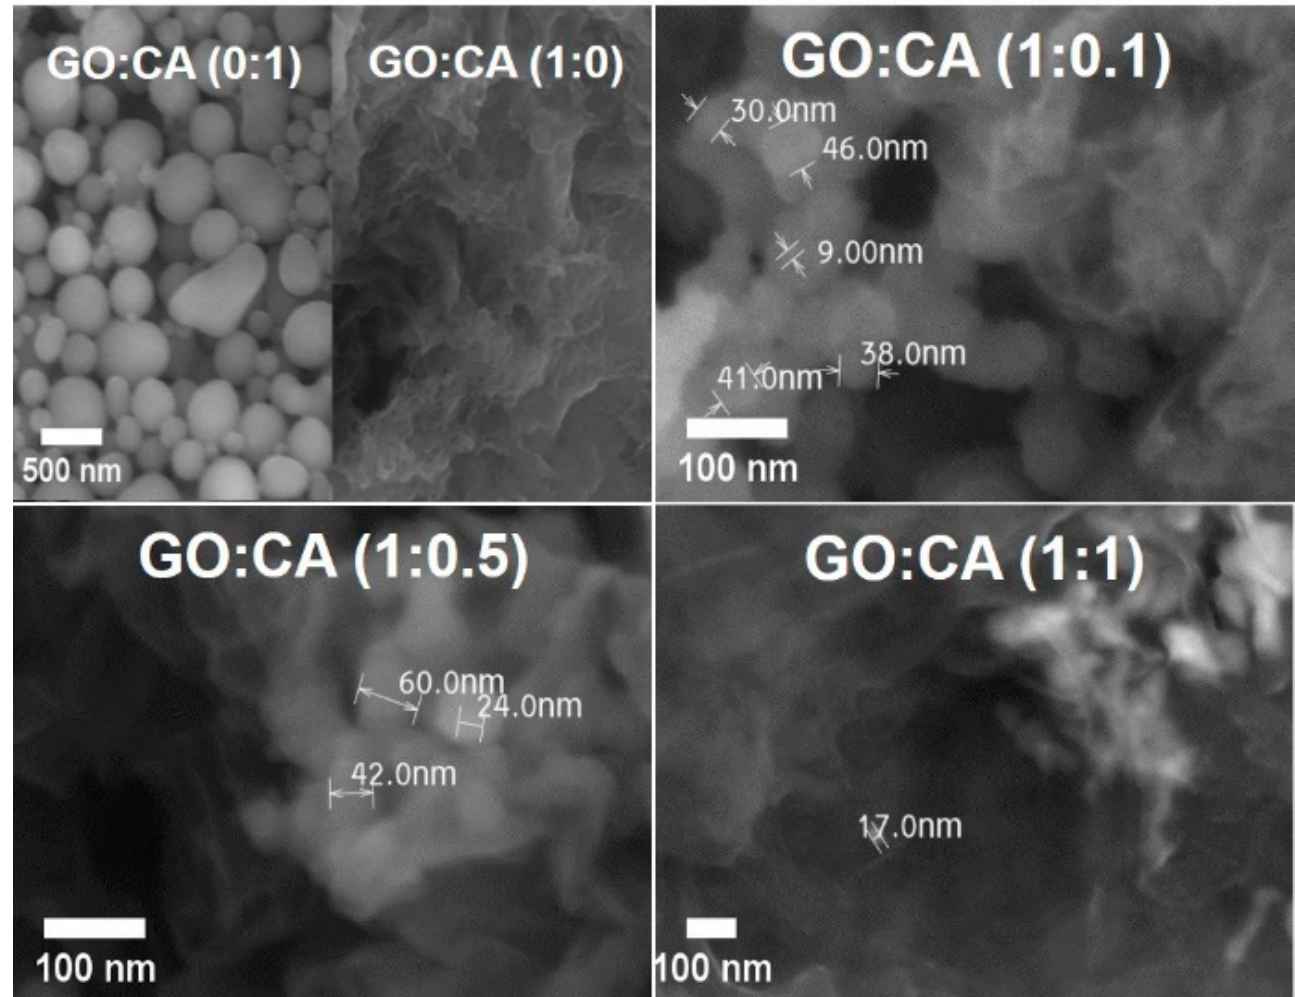
Figure 2. SEM micrographs of the reduced GO samples GO:CA (0:1), GO:CA (1:0), GO:CA (1:0.1), GO:CA (1:0.5) and GO:CA (1:1).